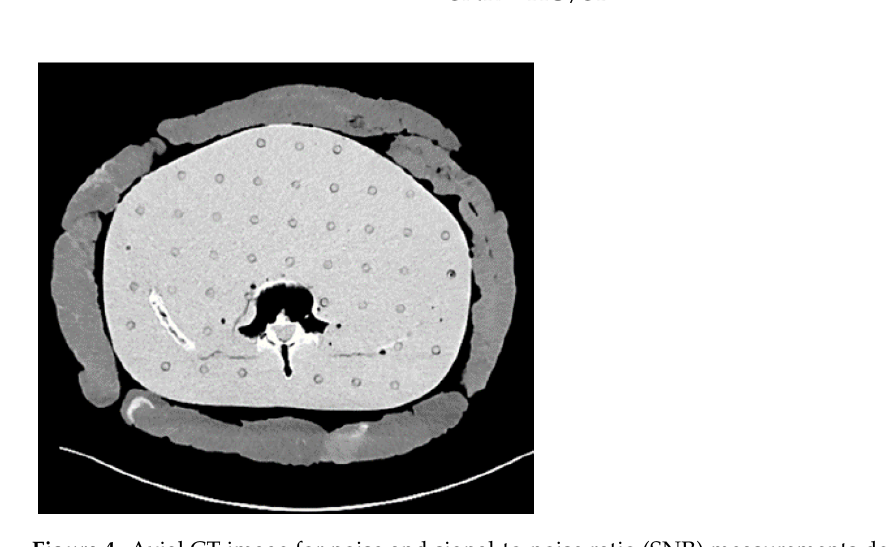
Figure 4. Axial CT image for noise and signal-to-noise ratio (SNR) measurements demonstrating region of interest (ROI)